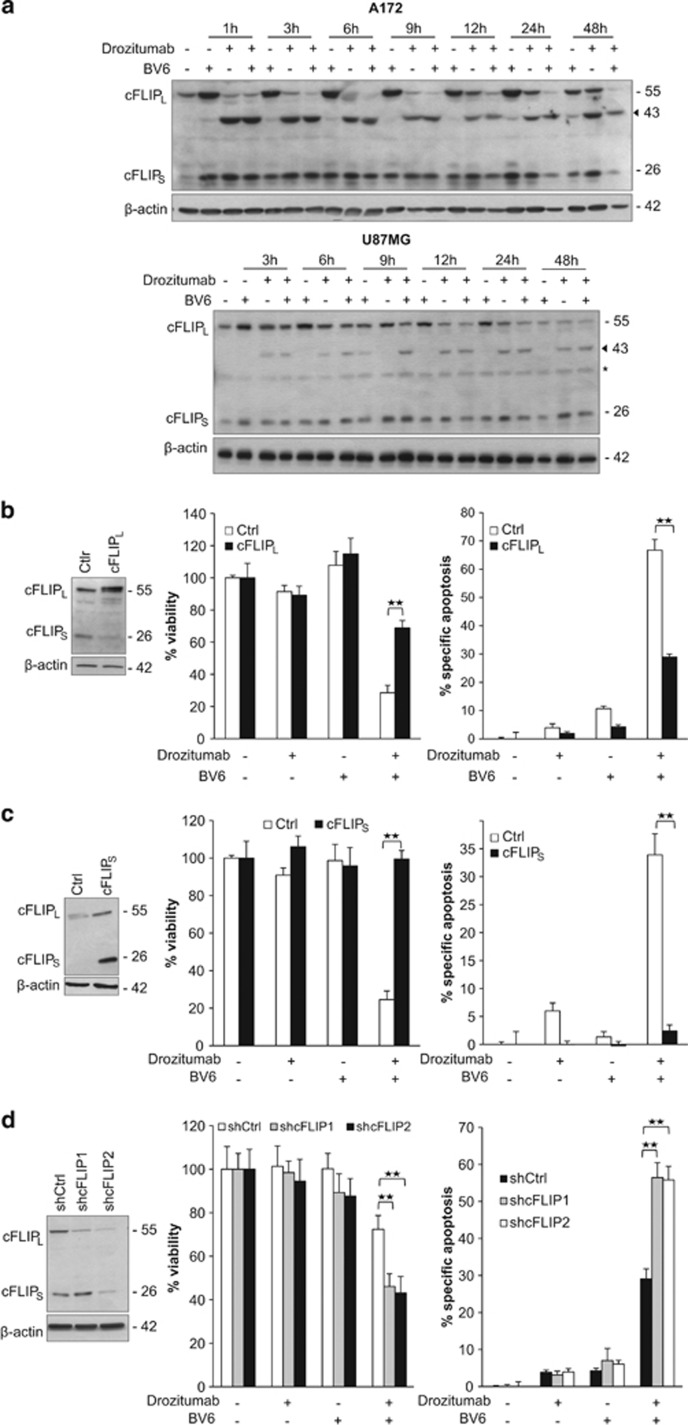
cFLIP is a key inhibitor of BV6- and Drozitumab-induced apoptosis. (a) A172 (upper panel) and U87MG (lower panel) cells were treated for indicated times with 0.3 μg/ml (A172) or 5 μg/ml (U87MG) Drozitumab and/or 3 μM (A172) or 4 μM (U87MG) BV6. cFLIP expression levels were analyzed by western blotting, arrowheads indicate cleavage fragments, asterisk indicates unspecific binding. A representative experiment of three independent experiments is shown. (b) U87MG cells were transduced with a vector containing cFLIPL or empty vector (Ctrl). Expression of cFLIP was assessed by western blotting (left panel). Cells were treated with 5 μg/ml Drozitumab and/or 4 μM BV6 for 72 h. Cell viability was determined by MTT assay and is expressed as percentage of untreated controls (middle panel). Apoptosis was determined by FACS analysis of DNA fragmentation of propidium iodide-stained nuclei (right panel). Data represent mean + S.E.M. of three independent experiments performed in triplicate; **P<0.001. (c) U87MG cells were transduced with a vector containing cFLIPS or empty vector (Ctrl). Expression of cFLIP was assessed by western blotting (left panel). Cells were treated with 5 μg/ml Drozitumab and/or 4 μM BV6 for 72 h. Cell viability was determined by MTT assay and is expressed as the percentage of untreated controls (middle panel). Apoptosis was determined by FACS analysis of DNA fragmentation of propidium iodide-stained nuclei (right panel). Data represent mean + S.E.M. of three independent experiments performed in triplicate; **P<0.001. (d) U87MG cells were transduced with control vector (shCtrl) or vectors containing two different shRNA sequences against cFLIP (shcFLIP1, shcFLIP2). Expression of cFLIP was assessed by western blotting (left panel). Cells treated with 0.3 μg/ml Drozitumab and/or 4 μM BV6 for 72 h. Cell viability was determined by MTT assay and is expressed as percentage of untreated controls (middle panel). Apoptosis was determined by FACS analysis of DNA fragmentation of propidium iodide-stained nuclei (right panel). Data represent mean + S.E.M. of three independent experiments performed in triplicate; **P<0.001